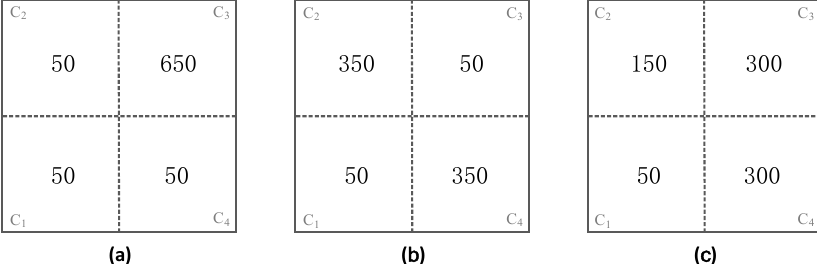
Figure 9. Three kinds of node deployments in Scenario 2: ( a ) C 1 , C 2 , C 4 are deployed with 50 nodes and C 3 is deployed with 650 nodes; ( b ) C 1 , C 3 are deployed with 50 nodes and C 2 , C 4 are deployed with 350 nodes; ( c ) C 1 is deployed with 50 nodes, C 2 is deployed with 150 nodes, C 3 and C 4 are all deployed with 300 nodes.